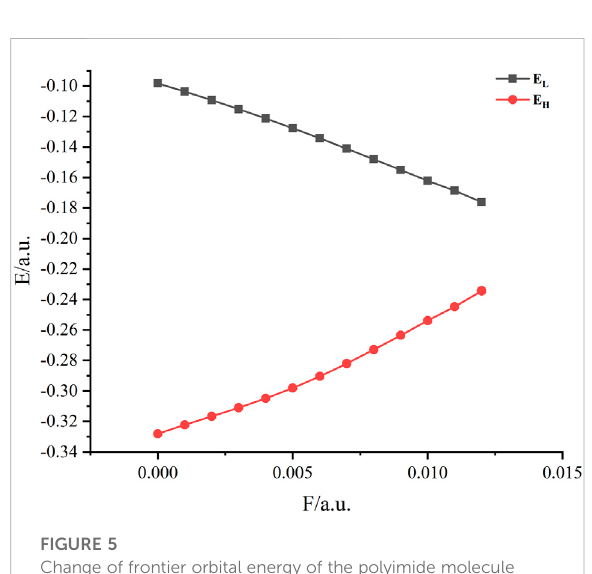
FIGURE 5 Change of frontier orbital energy of the polyimide molecule with electric fi